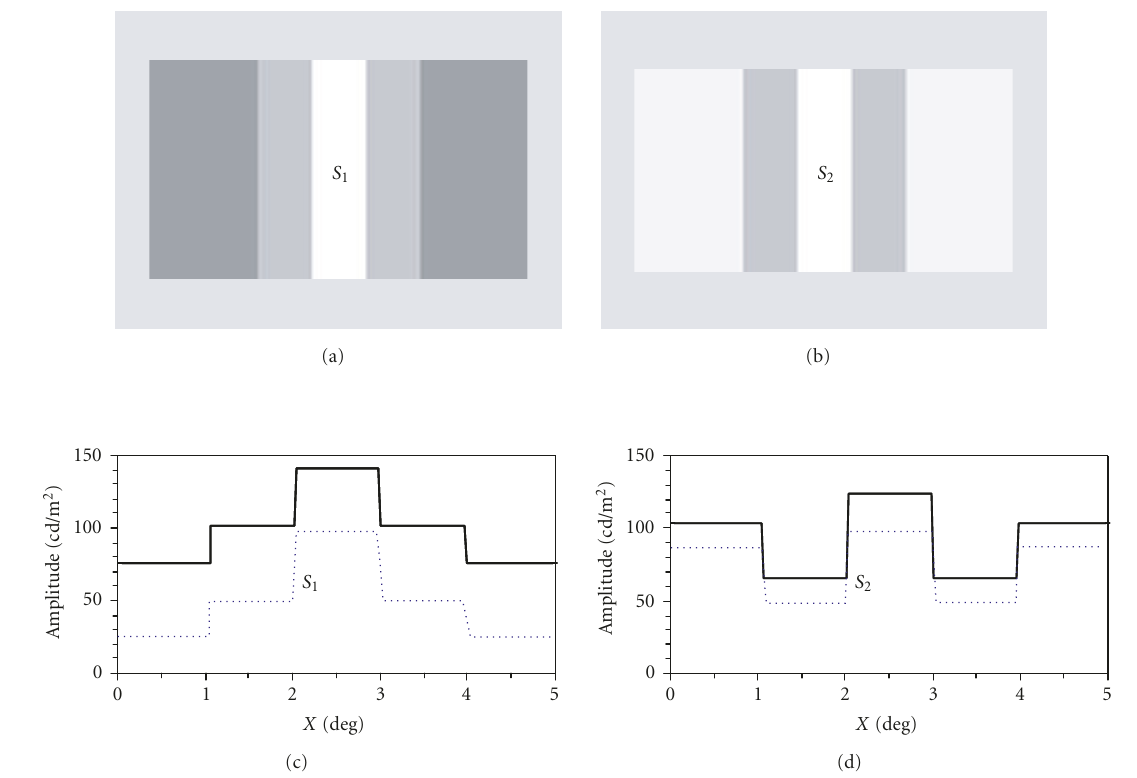
Figure 6: Panels (a) and (c) show two patterns to demonstrate the e ff ect of assimilation, where stripe S 1 looks brighter than S 2 while they have the same luminance value, and panels (b) and (d) show the luminance profile of the middle part 5 degrees of the patterns (dotted lines), and the corresponding model estimated brightness (thick lines) after a fill-in